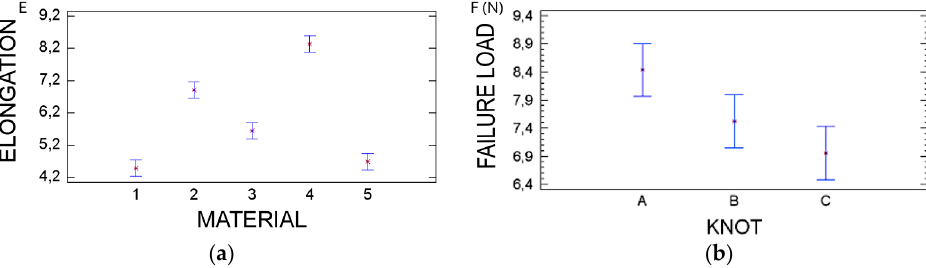
Figure 3. Tables for variables elongation and load failure ( a ) Elongation of suture materials at the three knot configurations; ( b ) Load failure of the suture materials to the different knot configurations.